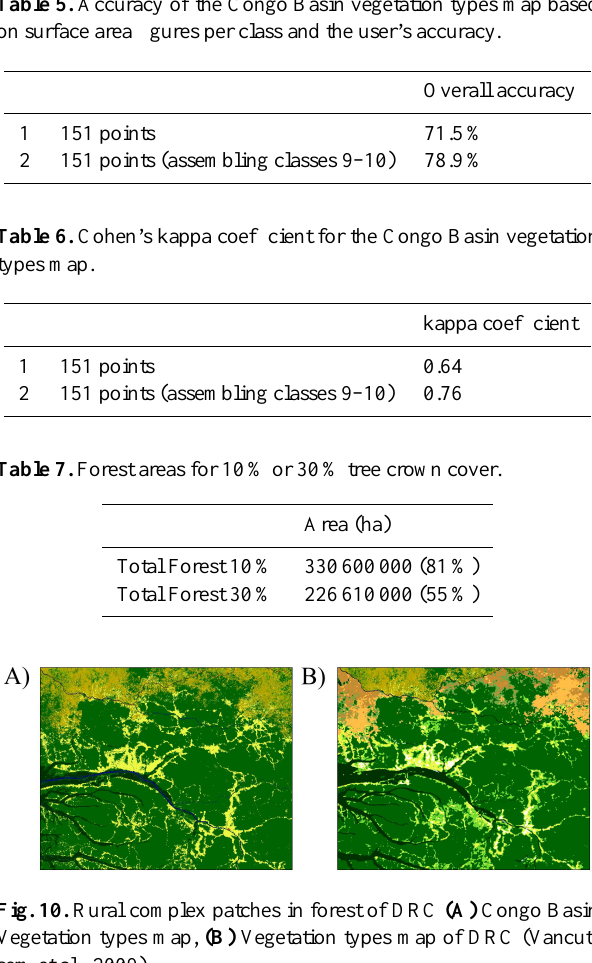
Fig. 12. Illustration of the smooth transition between the seasonal zones. The hatched area is the Eastern Centre (CE) zone. The boundary of this zone does not cause a sharp transition in the vege- tation